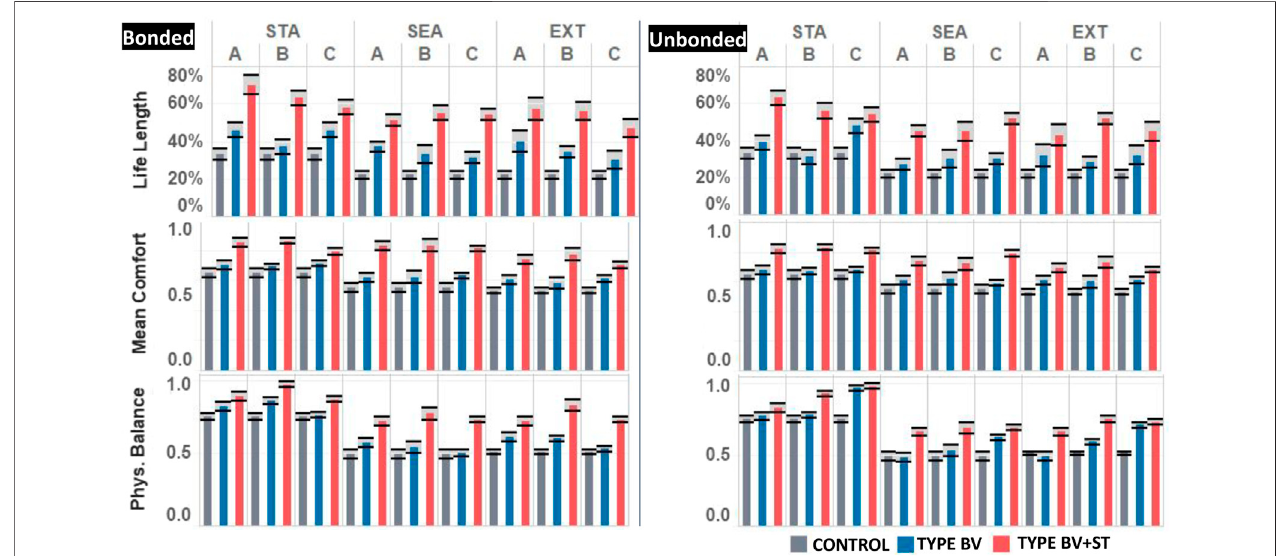
FIGURE 7 | Results of the three viability-related metrics by model type (Control, Type BV, Type BV+ST): aggregated by bonded (Bo) and unbonded (Unb) agents across all world (STA: Static, SEA = Seasonal, EXT = Extreme) and Bond (A,B,C) conditions. Black bars show standard error of mean values.